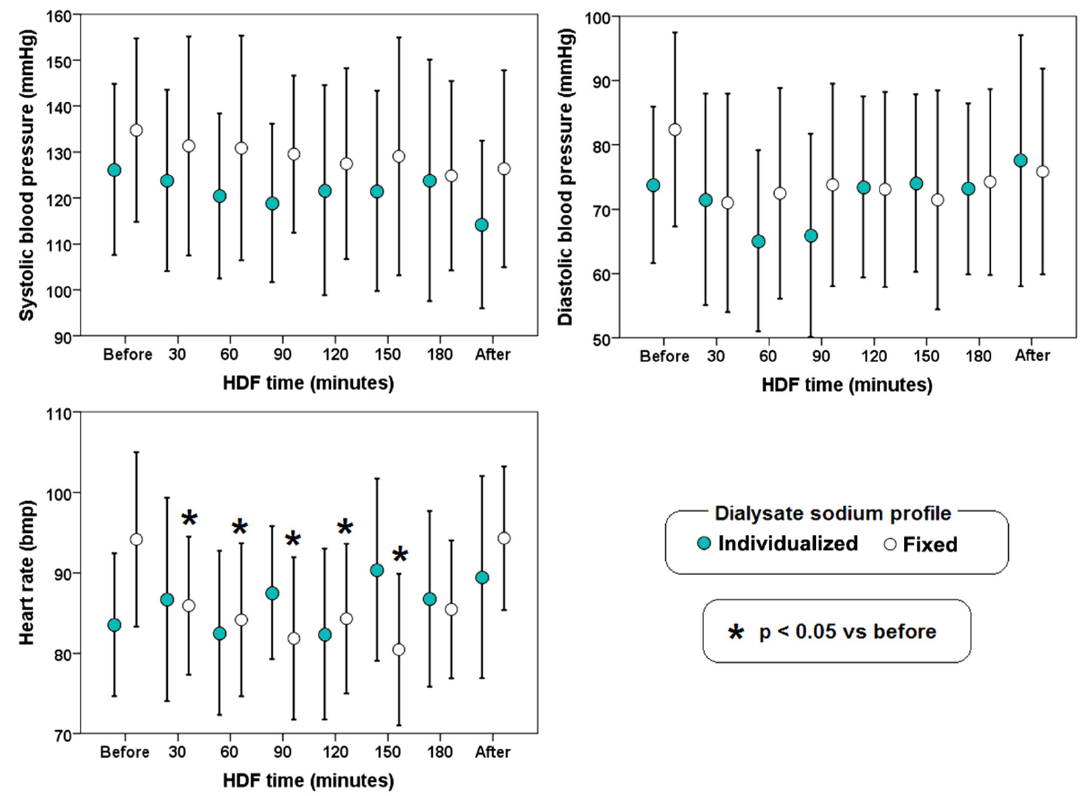
Figure 4. Blood pressure and heart rate during hemodiafiltration (HDF) with different dialysate sodium profiles (individualized or fixed at 138 mmol/L). The error bars indicate one standard deviation.